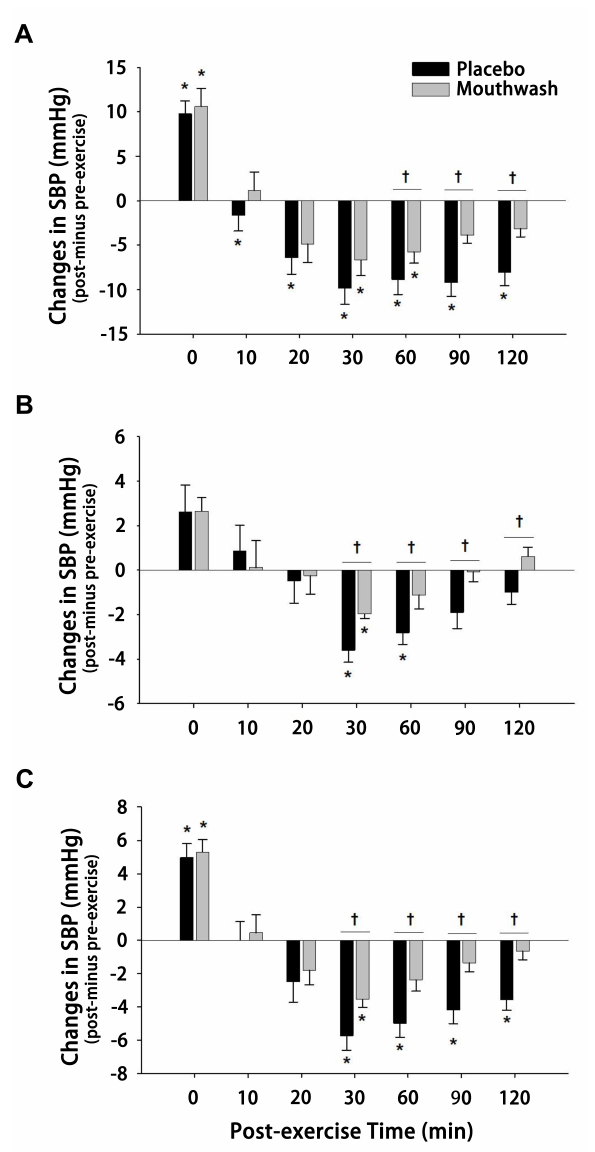
Fig. 3. Changes (post-exercise minus pre-exercise values) in (A) systolic blood pressure (SBP), (B) diastolic blood pressure (DBP) and (C) mean arterial pressure (MAP) during the re- covery period (0 to 120 min). Values are presented as mean ± SEM. *, p < 0.05 compared with pre-exercise values. †, p < 0.05 between treatments.